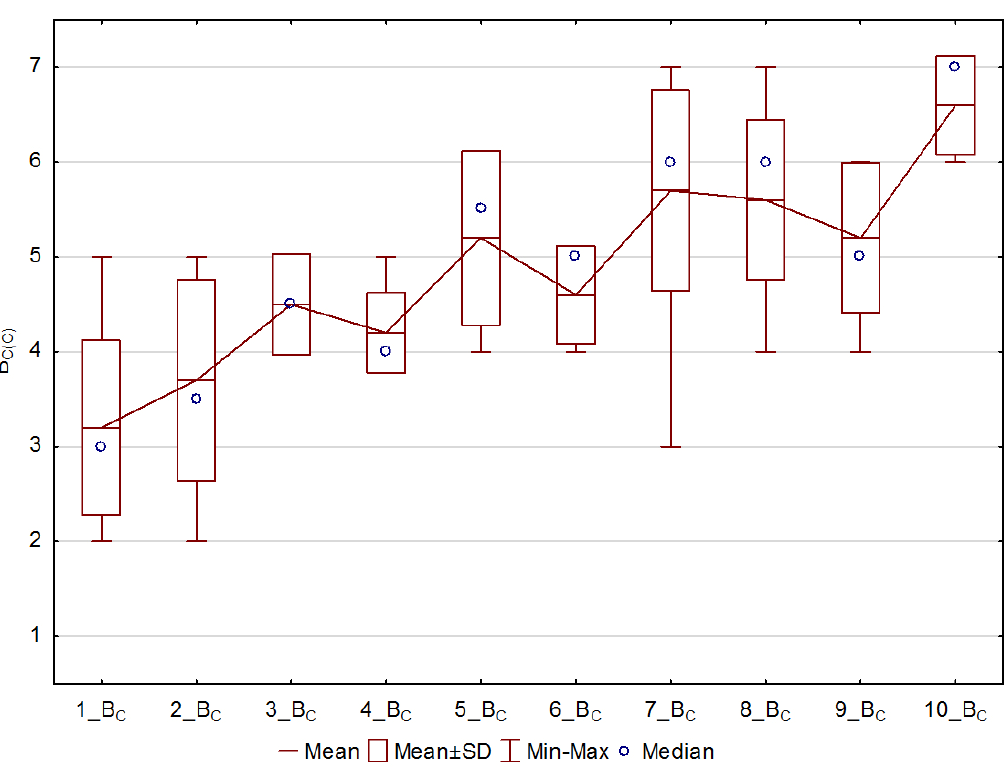
Figure 24. Ceiling brightness perception for group C.